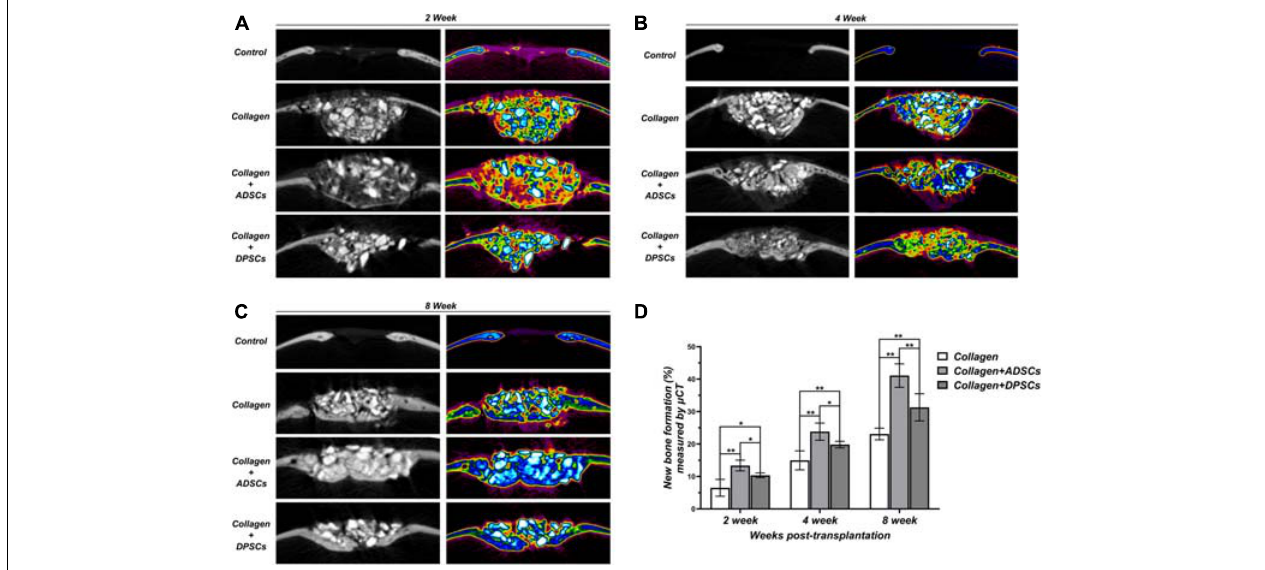
FIGURE 4 | Sagittal images of µ -CT examinations in the region of interest (ROI) of Control, Bio-Oss Collagen, Bio-Oss Collagen + ADSCs, and Bio-Oss Collagen + DPSCs groups at (A) 2 weeks, (B) 4 weeks and (C) 8 weeks. Left panels: black-white tomograms. Right panels: images of equal-density pseudocolor. (D) Quantitative analysis of the new bone formation by using µ -CT examinations and pseudocolor processing. Data are presented as the mean ± standard deviation, * P < 0.05, ** P <